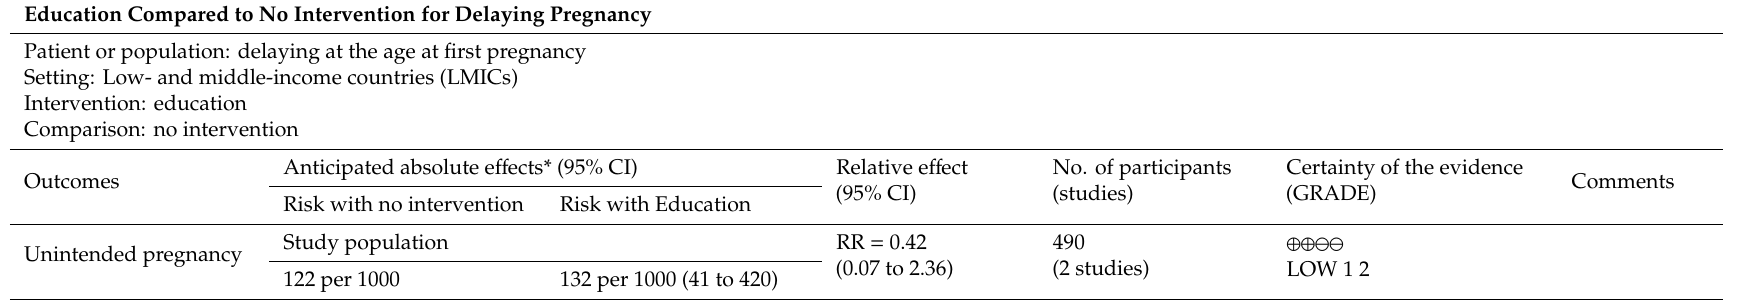
Table 2. Delay in age of first pregnancy—Education vs. no intervention.